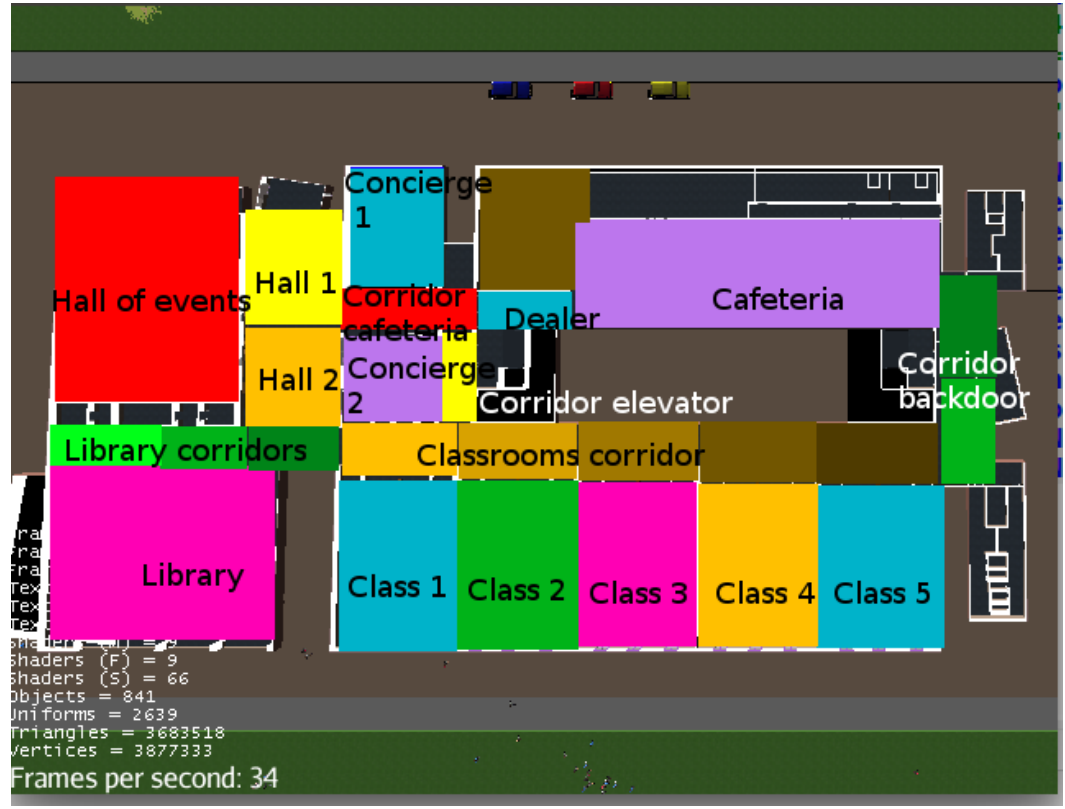
Figure 4. The division of the environment in Regions. (Capture obtained from the MASSIS simulator. Leyend layer added